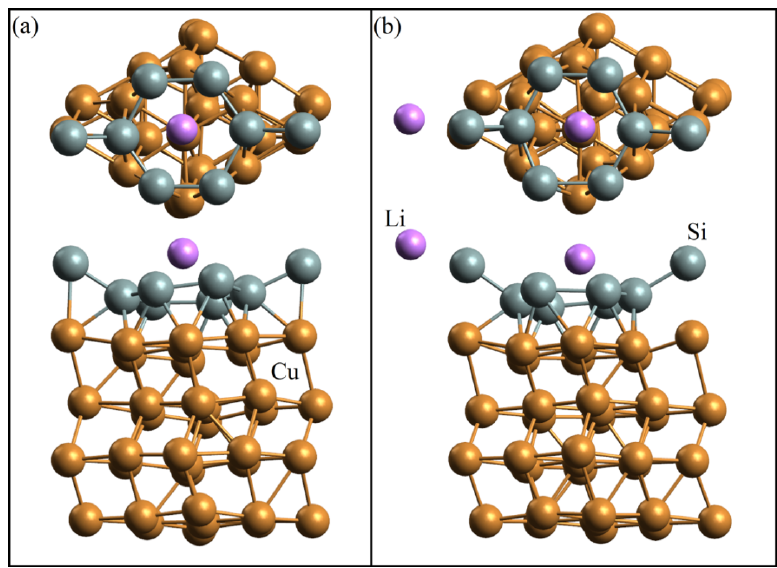
Figure 5. Geometric structures of silicene on the four-layer copper substrate with the addition of ( a ) one and ( b ) two Li atoms (after 2000 ps at a temperature of 293 K).